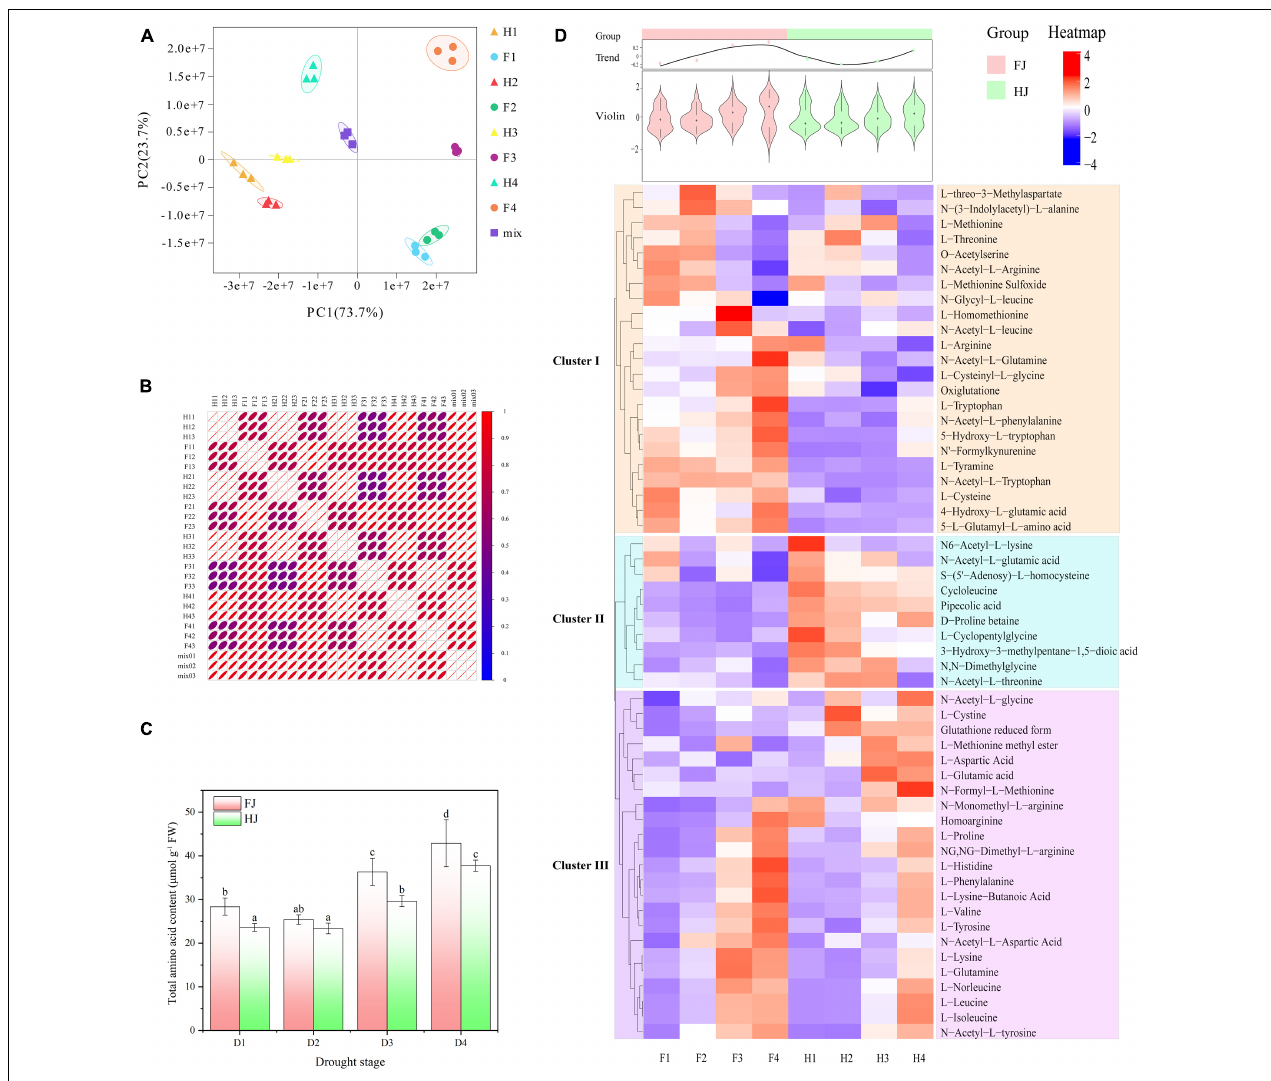
FIGURE 1 | Amino acid profile analysis in ZB leaves under drought stress. (A) Principle component analysis (PCA) of 24 ZB leaf samples. (B) Intragroup correlation analysis of 24 ZB leaf samples. (C) Total amino acid content of ZB leaves under progressive drought stress. Red columns indicating the total amino acid content in ZB cultivar FJ; green columns indicating the total amino acid content in ZB cultivar HJ. D1, D2, D3, and D4 indicating the ZB leaves sampled 0, 6, 9, and 15 days after drought treatment. (D) Hierarchical clustering heatmap analysis (HCA) indicating the abundance of 56 individual amino acids in ZB leaves. Red and blue representing the high and low amino acid abundance, respectively. The above violin diagram and curve chart indicating the total variation in the 56 individual amino acids. F1, F2, F3, and F4 indicating the FJ samples in D1, D2, D3, and D4, respectively; H1, H2, H3, and H4 indicating the HJ samples in D1, D2, D3, and D4,